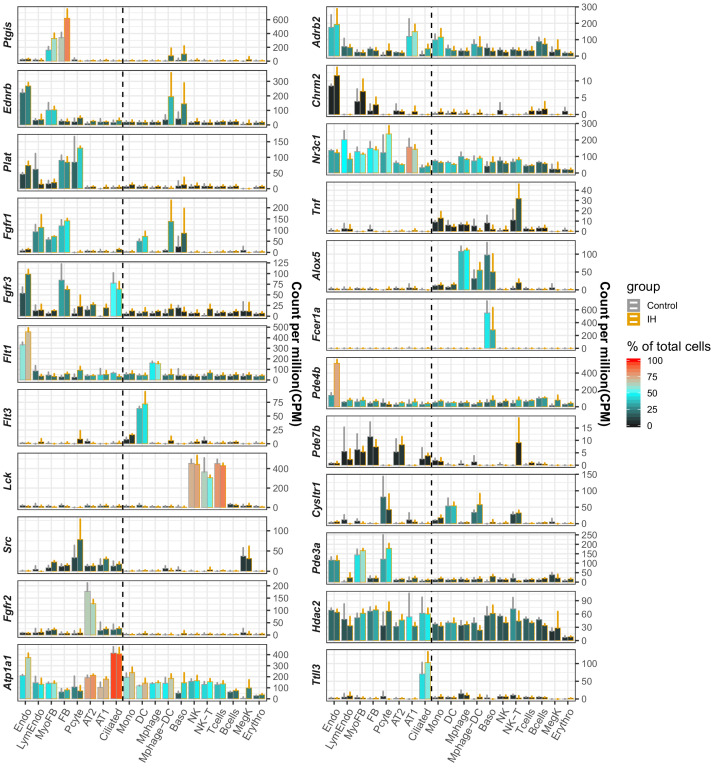
Pulmonary drug targets with cell type-specific expression profiles in mouse lung.The average CPM (count per million reads) of three controls (gray) and IH-exposed (orange) replicates are indicated by the height of the bar. The error bar indicates standard deviation from the three biological replicates. The average percentage of cells with detected expression of each marker gene among specific cell types is indicated by the color scale. The list of cell types include endothelial cells (Endo), B cells (Bcells), natural killer cells (NK), T cells (Tcells), natural killer T cells (NK-T), macrophages (Mphage), basophils (Baso), monocytes (Mono), macrophages-dendritic CD163+ cells (Mphage-DC), dendritic cells (DC), megakaryocytes (MegK), fibroblasts (FB), myofibroblasts (MyoFB), pericytes (Pcyte), alveolar epithelial type I cells (AT1), lymphatic endothelial cells (LymEndo), erythroblasts (Erythro), alveolar epithelial type II cells (AT2), and ciliated cells (Ciliated).